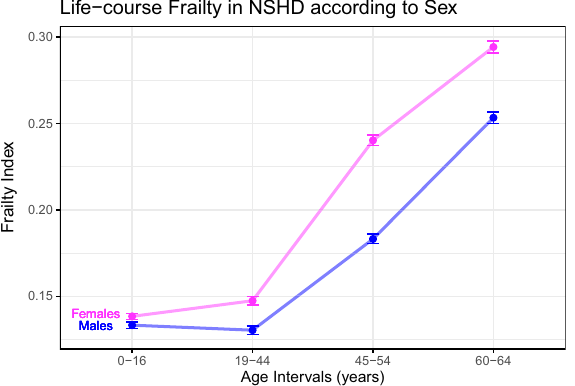
Figure 2. Sex differences in life-course burden of health deficits in the NSHD cohort. Females (pink) had higher FIs ( y -axis) than males (blue) at every time period ( x -axis). Vertical bars represent standard error of the means. Abbreviations as in Fig. 1.